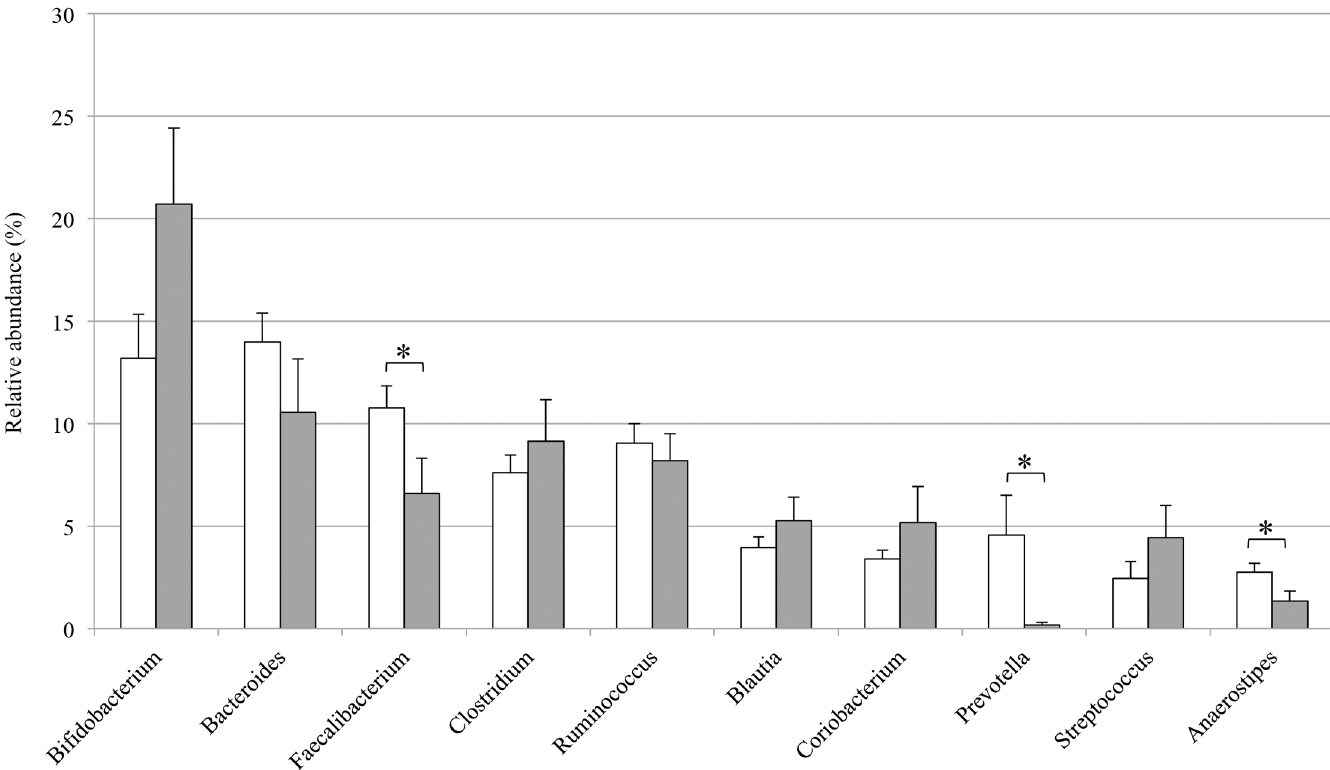
Fig 4. Bacterial composition at the genus level in gut microbiota samples obtained from HC40 and MS20 subjects. For genus-level assignment of 16S reads (16S rRNA gene V1-V2 region) mapped to the known FL-16S sequences and unmapped OTUs (see Results), 94% sequence identity threshold was applied. The vertical axis represents the relative abundance (%) of each genus in the microbiota of HC40 (open bar) and MS20 (grey bar) subjects. Error bars represent standard error of the mean. Asterisks indicate statistical significance determined by Welch ’ s t test ( * P < 0.05).